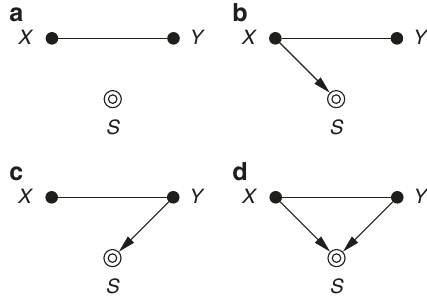
Fig. 4 Causal diagrams for different sample selection scenarios. a Random; b image-dependent; c target-dependent; d jointly dependent. S = 1 indicates an observed sample, and plain edges represent either